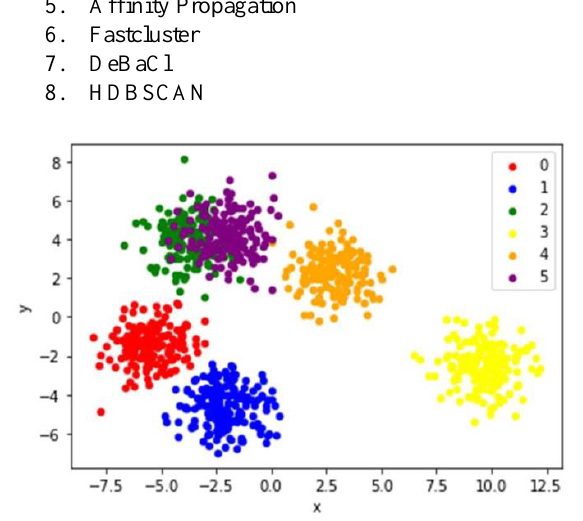
Figure 5. Dataset Sub-Type 1 (Blobs)